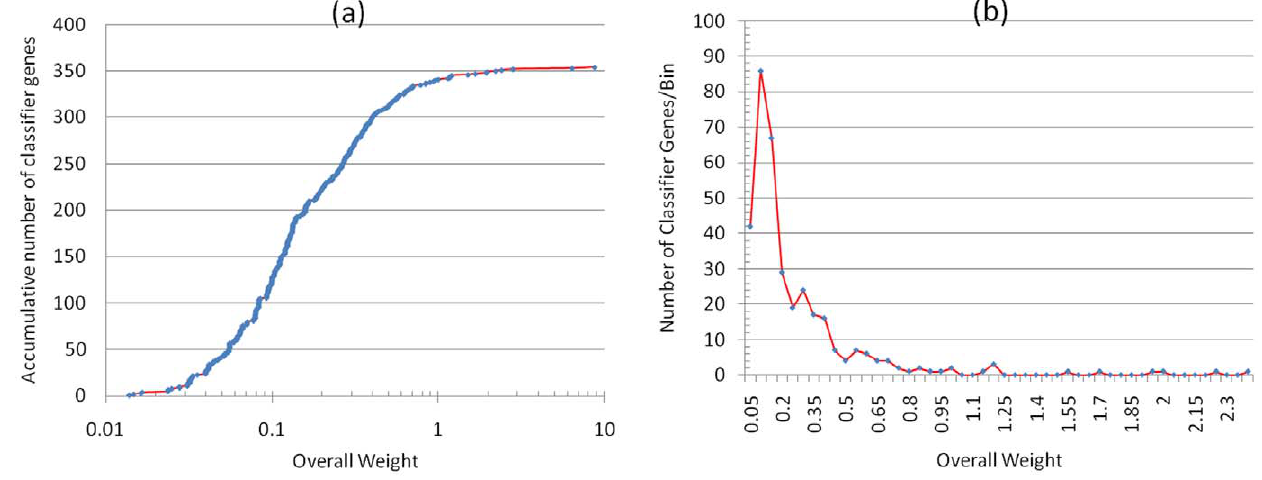
Figure 3. The accumulative distribution (a) and histogram (b) of the overall weight of the 354 selected classifier genes. In the histogram, the bin size is set at 0.05, and three genes with the highest overall weight of 2.81, 6.38 and 8.70, respectively, are not shown. doi:10.1371/journal.pone.0013715.g003 PLoS ONE |